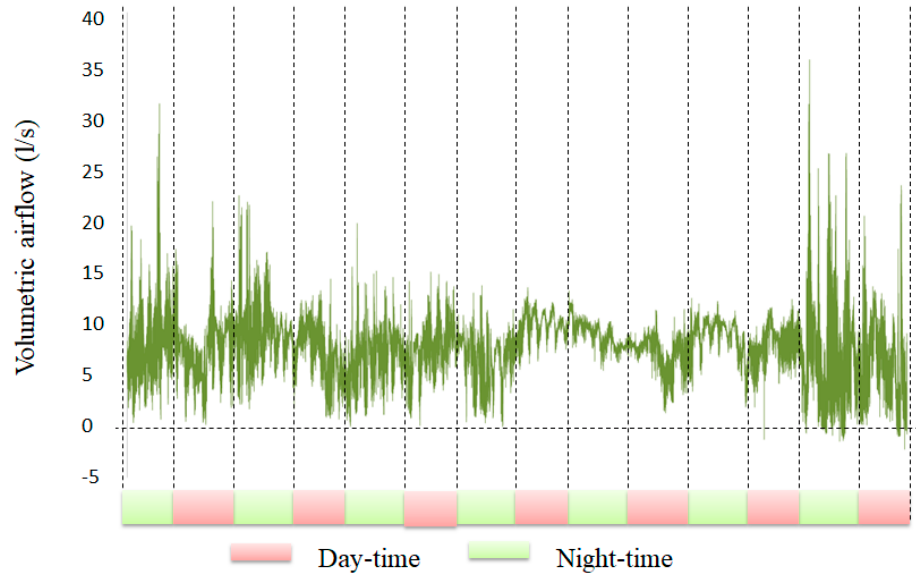
Figure 11. Time-variation of leakage flow rate in test apartment.